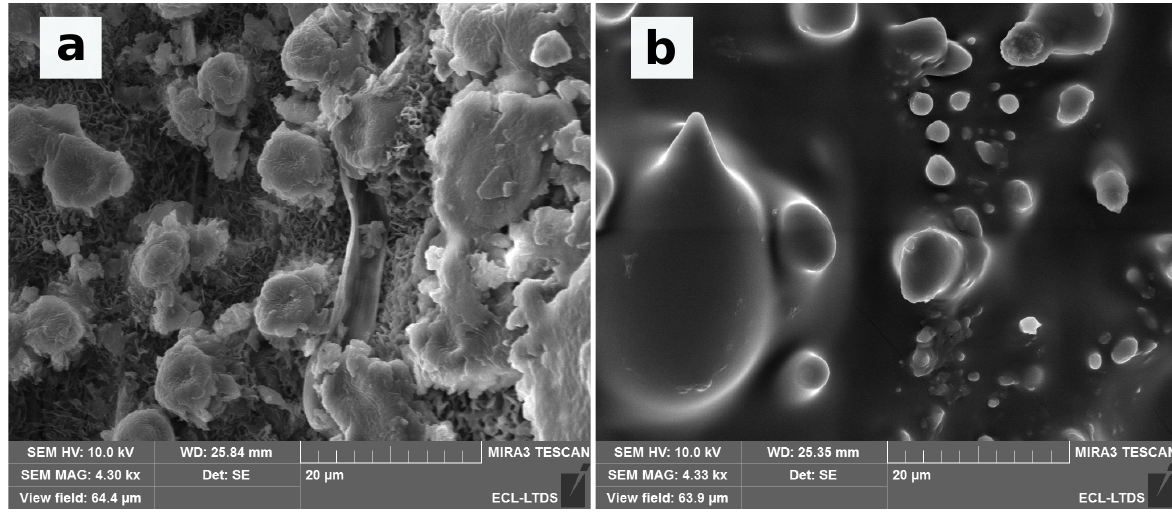
Figure 8. SEM images of ( a ) Phyllostachys leaves and ( b ) Phyllostachys replicas. Table 2. Topographic parameters measured on natural and replicated surfaces, based on interferometric measurements at × 10 magnification. The standart deviations associated with the S a and S q parameters are the maximum values of standard deviation for these